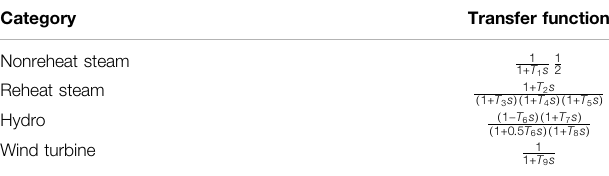
Frontiers in Energy Research |